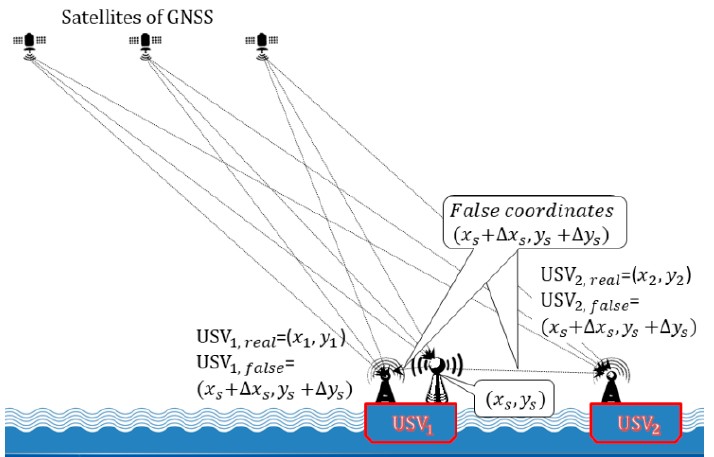
Figure 8. The basic GNSS self-spoofing scheme of USVs: at some point in time, the self-spoofer determines its position ( x s , y s ) , introducing some delays into each of the satellite channels, introducing some other signal distortion, and transmitting the false position ( x s + ∆ x s , y s + ∆ y s ) on the same frequency, which aims to deceive GNSS receivers and create a false PVT solution. All USVs in the self-spoofer activation zone are positioned as USV i , false = ( x s + ∆ x s , y s + ∆ y s From a technical point of view, the GNSS self-spoofing of USVs is the same spoofing, but here we have an absolutely different way of using spoofing, and if conventional anti-spoofing is based on the choice of technical means to protect oneself from spoofing, then anti-self-spoof- ing is based on the choice of technical means for attacking this self-spoofing in order to neu- tralize it, or at least to register the fact of its use by some vehicle including USV.